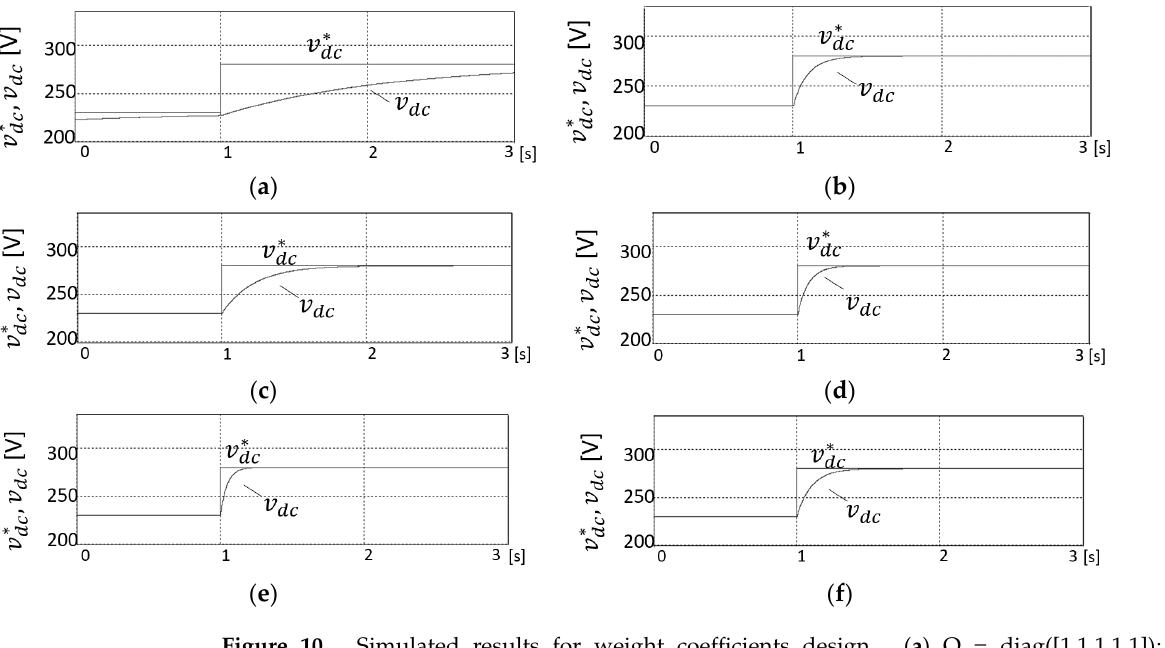
Figure 10. Simulated results for weight coefficients design. ( a ) Q = diag([1,1,1,1,1]); ( b ) Q =